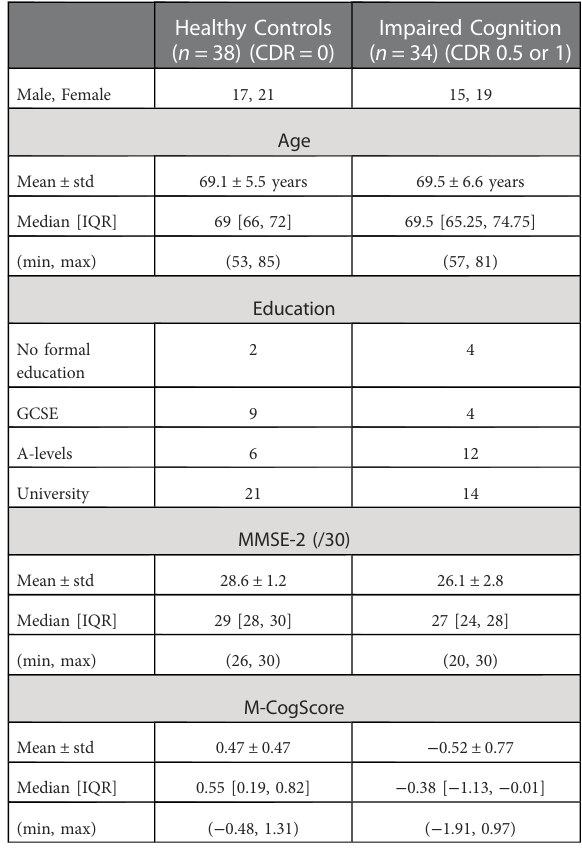
TABLE 1 Demographics of all participants and summary MMSE-2 and M-CogScore results by CDR score. Healthy Controls ( n = 38) (CDR =